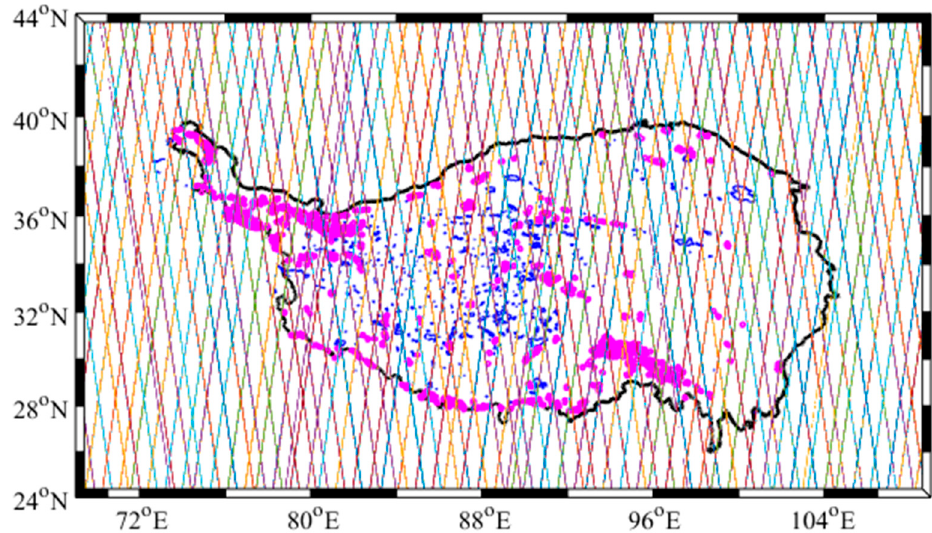
Figure 2. ICESat ground tracks on the Tibetan Plateau over the period from March 2003 to October 2009. Lakes are in blue and glaciers in red.